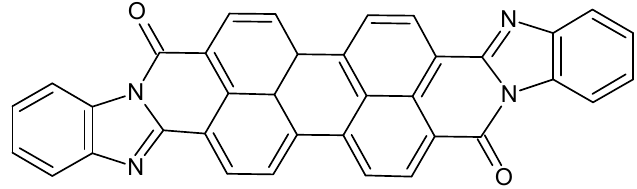
Figure 23. Chemical structures of the perylene derivative PDI used in [124].